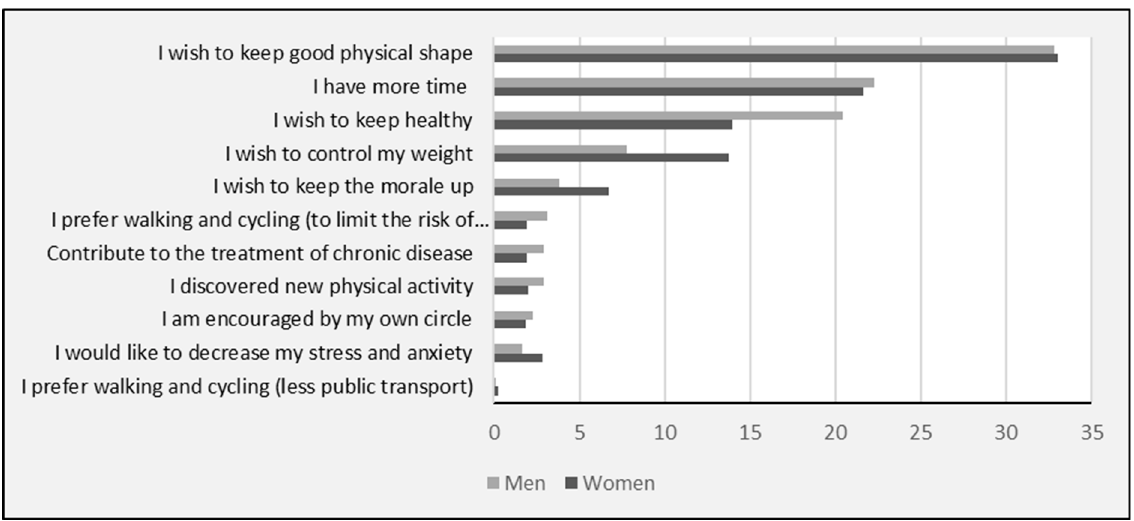
Figure 2. Main reasons (in %) reported by women (n = 3430) and men (n = 866) to explain increased physical activity (T1).